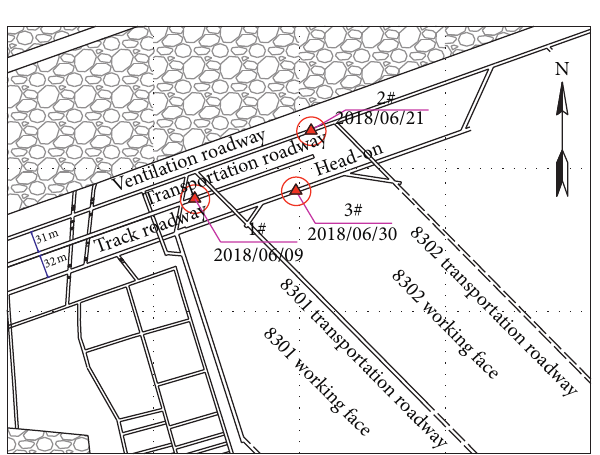
Figure 11: Diagram of the mining and excavation of the third mining